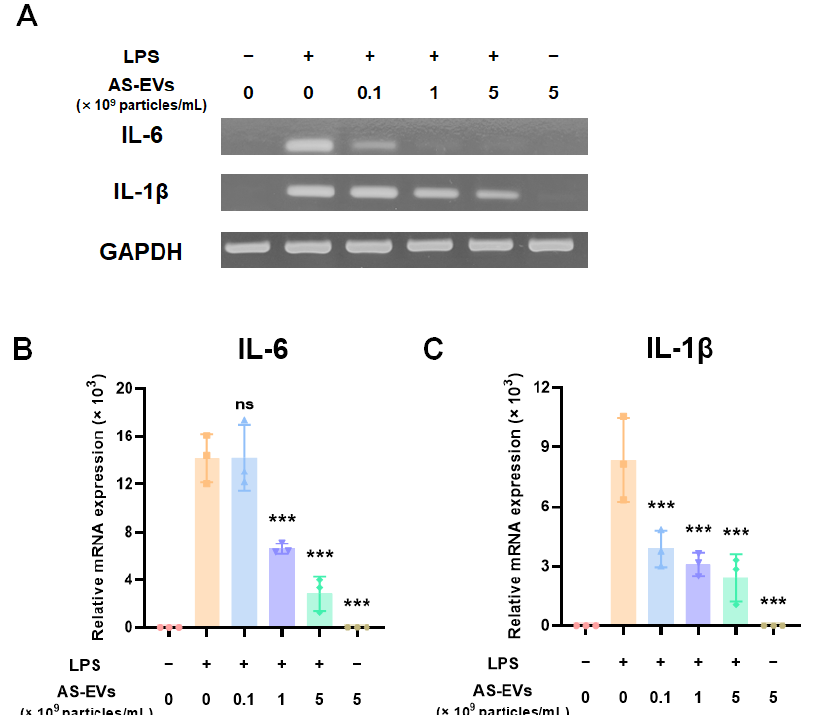
Figure 3. Effect of AS ‐ EVs on expression of pro ‐ inflammatory cytokines in LPS ‐ stimulated RAW 264.7 cells. ( A ) RT-PCR analysis of IL-6 and IL-1 β mRNA expression in AS-EV-treated cells 264.7 cells. ( A ) RT ‐ PCR analysis of IL ‐ 6 and IL ‐ 1 β mRNA expression in AS ‐ EV ‐ treated cells followed by induction of inflammatory response by LPS treatment. ( B , C ) The mRNA expression levels IL ‐ 6 and IL ‐ 1 β in AS ‐ EV ‐ treated cells were quantitatively analyzed by qPCR analysis. AS ‐ EVs reduced the expression of LPS ‐ induced pro ‐ inflammatory mRNAs. Statistical significance was determined by comparison with the control group not treated with AS ‐ EVs (*** p < 0.005, ns: not significant, n = 3).